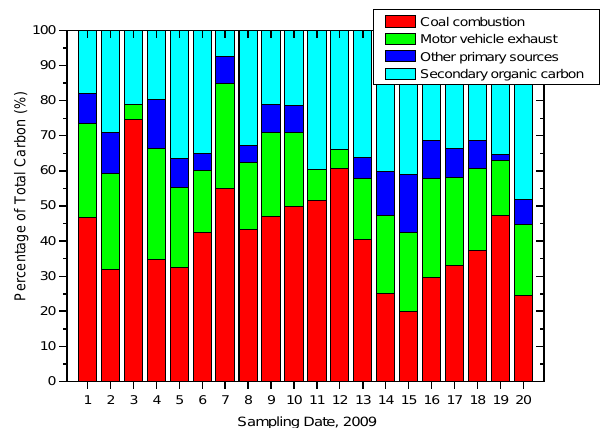
Fig. 6. Relative contributions of different sources to total carbon during 1–20 September